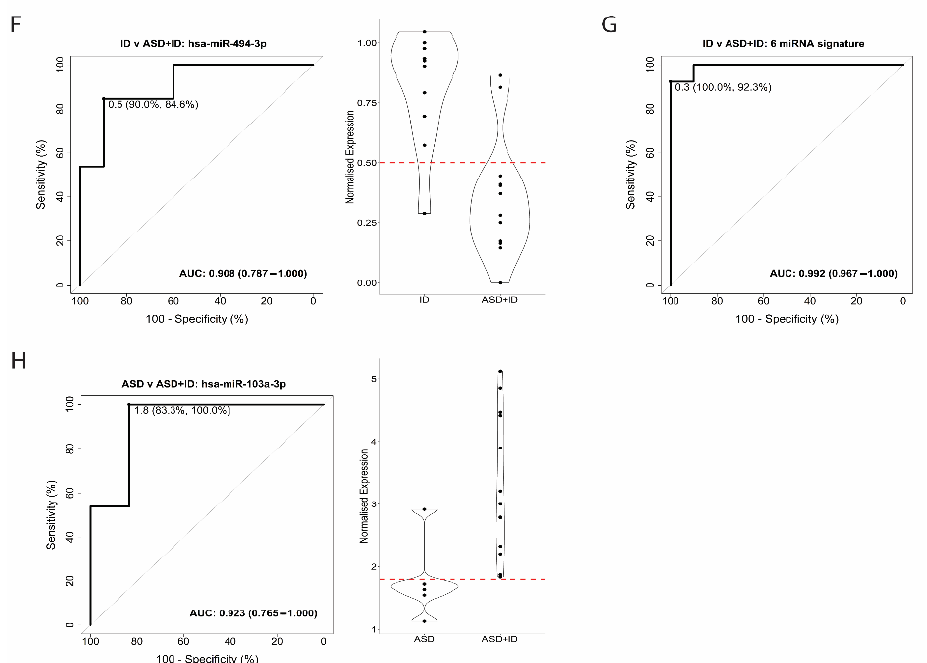
Figure 1. Receiver operating characteristic (ROC) curve analysis and violin plots for Intellectual Disability (ID), and Autism Spectrum Disorder (ASD), ASD + ID, as well as for discriminating between ID and ASD + ID and between ASD and ASD + ID. ( A ). ROC curve analysis for the miRNAs showed 100% sensitivity and 73.3% specificity for hsa-miR-409-5p in discriminating between controls (TSC without TANDs) and ID, corresponding to an AUC of 0.880. ( B ). Panel of four miRNAs signature discriminating between controls (TSC without TANDs) and ID. ( C ). For the discrimination between controls (TSC without TANDs) and ASD, hsa-let-7i-3p showed a 100% sensitivity and 80% specificity corresponding to an AUC of 0.894. ( D ). Panel of two miRNAs signature discriminating between controls (TSC without TANDs) and ASD. ( E ). For the discrimination between controls (TSC without TANDs) and ASD + ID, hsa-miR-214-5p showed 84.6% sensitivity and 73.30% specificity, corresponding to an AUC of 0.817. ( F ). For the comparison between ID and ASD + ID, hsa-miR-494-3p showed an 84.6% sensitivity and a 90% specificity, corresponding to an AUC of 0.908. ( G ). Panel of six miRNAs signature discriminating between ID and ASD + ID. ( H ). For the discrimination between ASD and ASD + ID, hsa-miR-103a-3p showed a 100% sensitivity and 83.3% specificity, corresponding to an AUC of 0.923. X-axis ROC curve: 100-Specificity in percentage (%); Y-axis ROC curve: Sensitivity in percentage (%); X-axis violin plot: Groups; Y-axis violin plot: Normalized expression. The red dotted line in each violin plot indicates the threshold that optimizes group